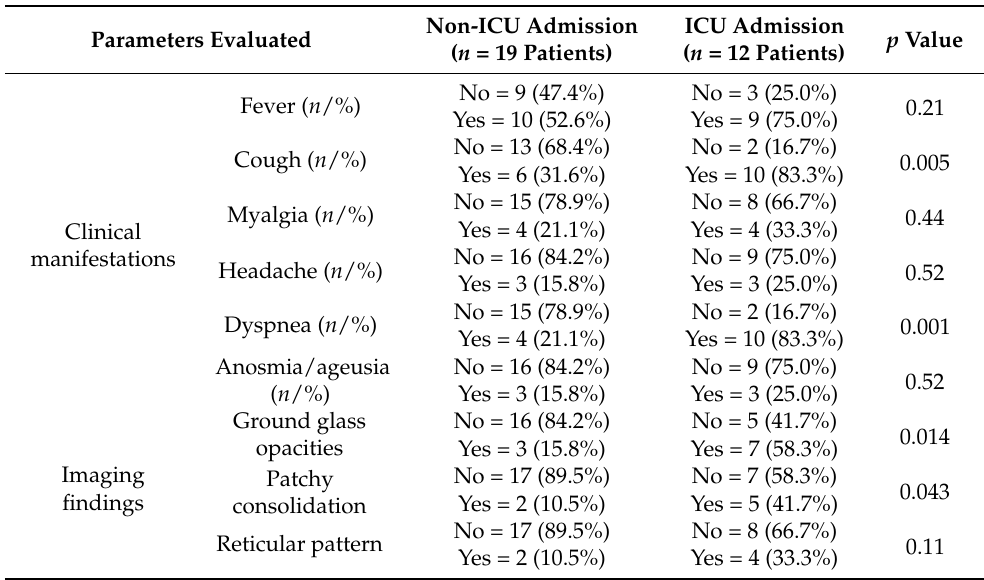
Table 2. A univariate analysis of the clinical manifestations and imaging findings for patients included in our study.